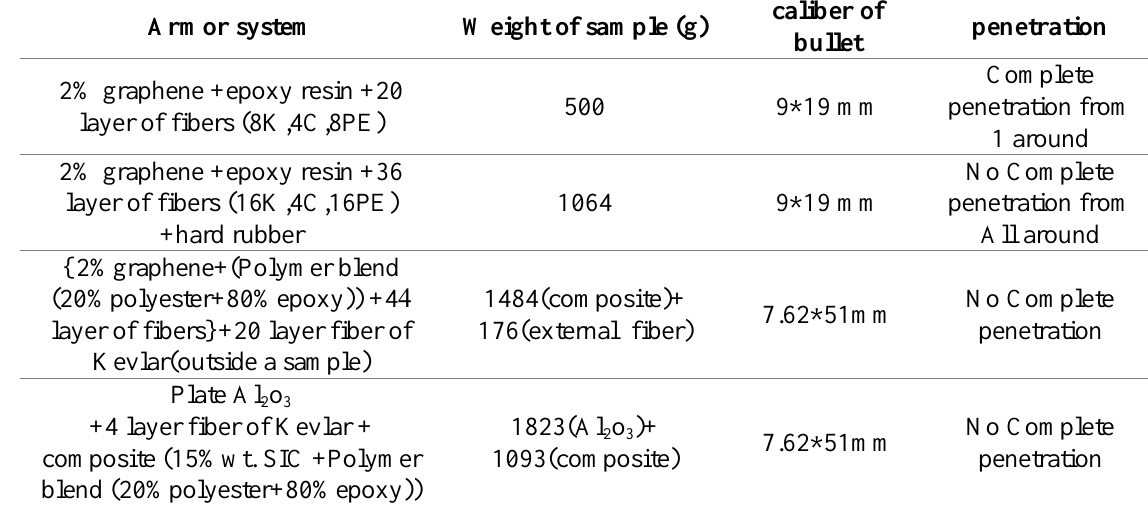
Table 1: The system of armor